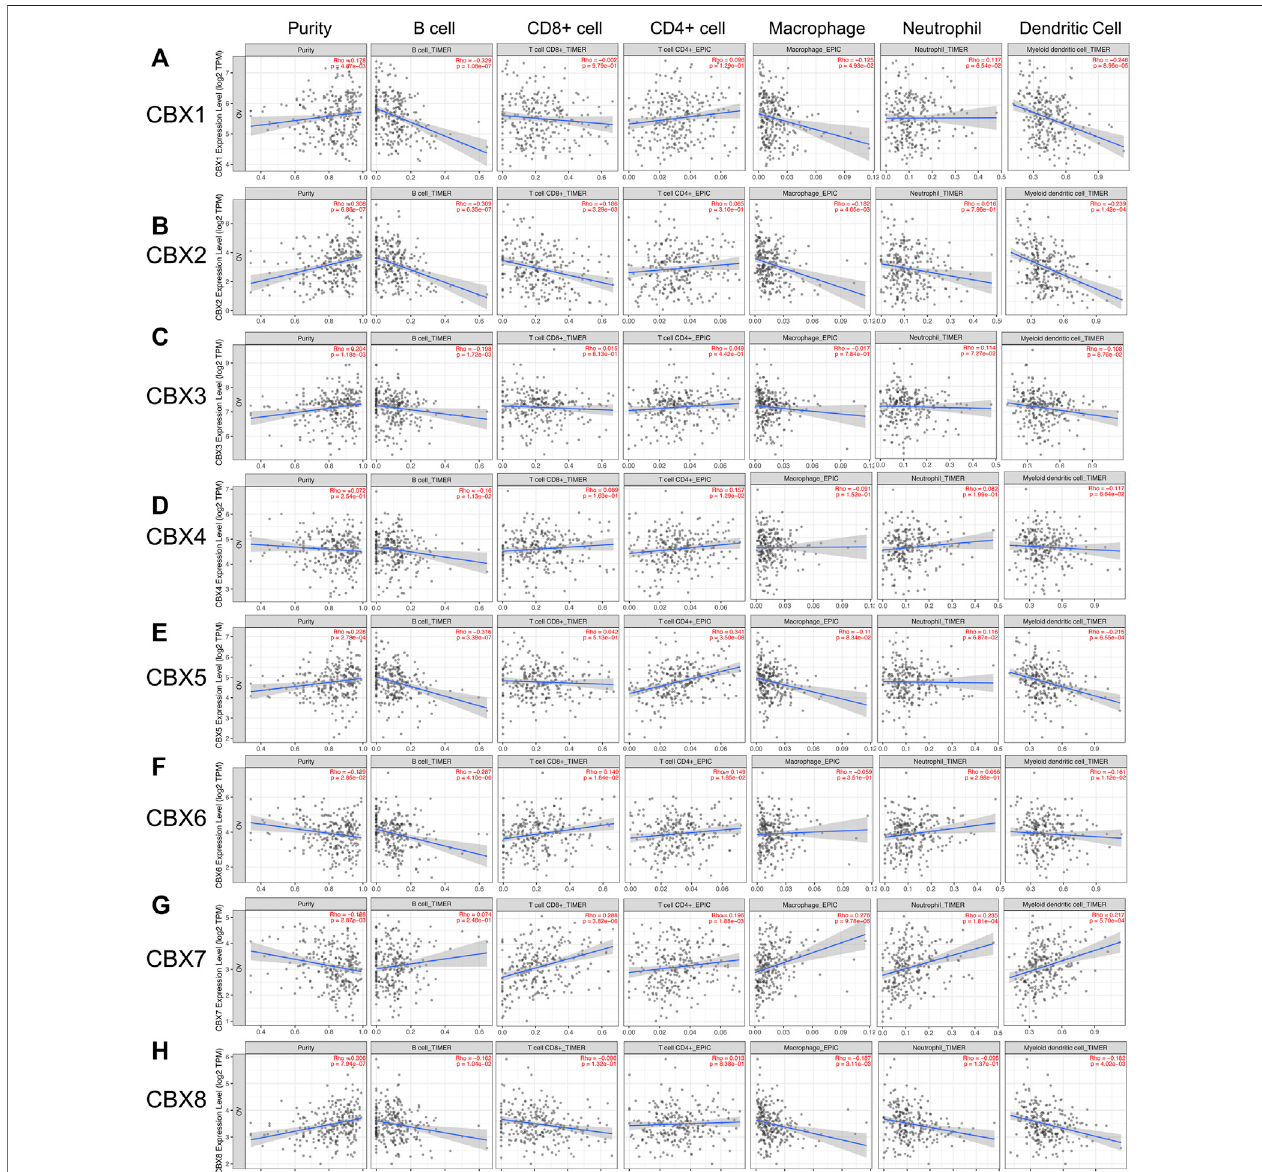
FIGURE 9 | The correlations between differentially expressed CBXs family members and immune cell in fi ltration. (A – H) The effects of CBX1-8 on the immune cell in fi ltration were analyzed by TIMER2.0. Six immune cells were analyzed including B cells, CD8 + T cells, CD4 + T cells, macrophages, neutrophils, and dendritic cells.